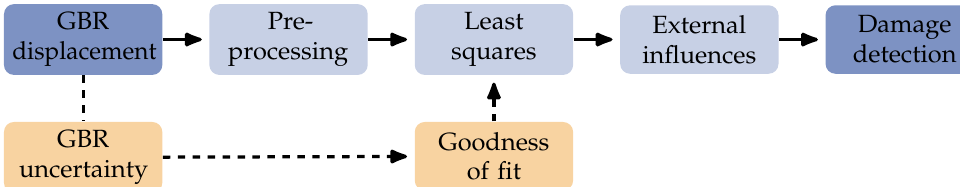
Figure 1. Overview of the frequency estimation approach for damage detection with GBR